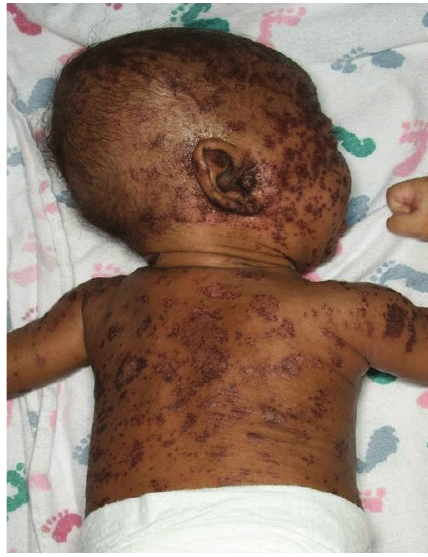
Figure 1: Di ff use rash in an infant with ADA deficiency.